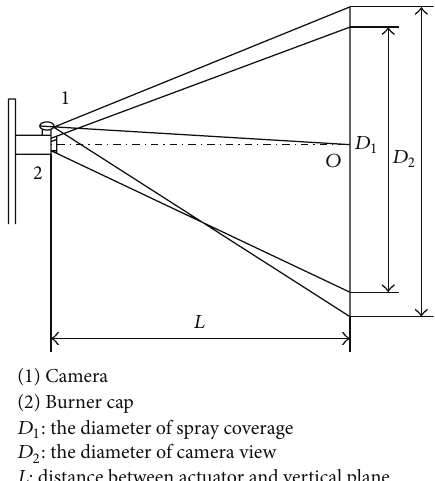
Figure 5: Sketch map of the spray coverage and the camera visual field coverage.